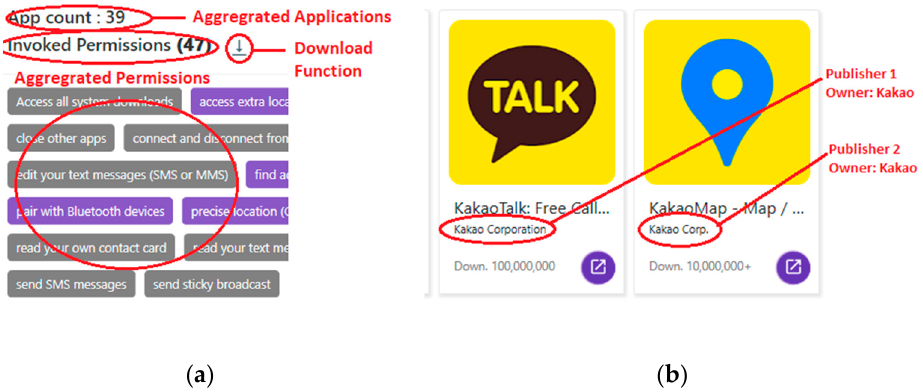
Figure 6. ‘Privacy analysis on mobile App’ web application. ( a ) Aggregated app and permission overview and ( b ) application detail.